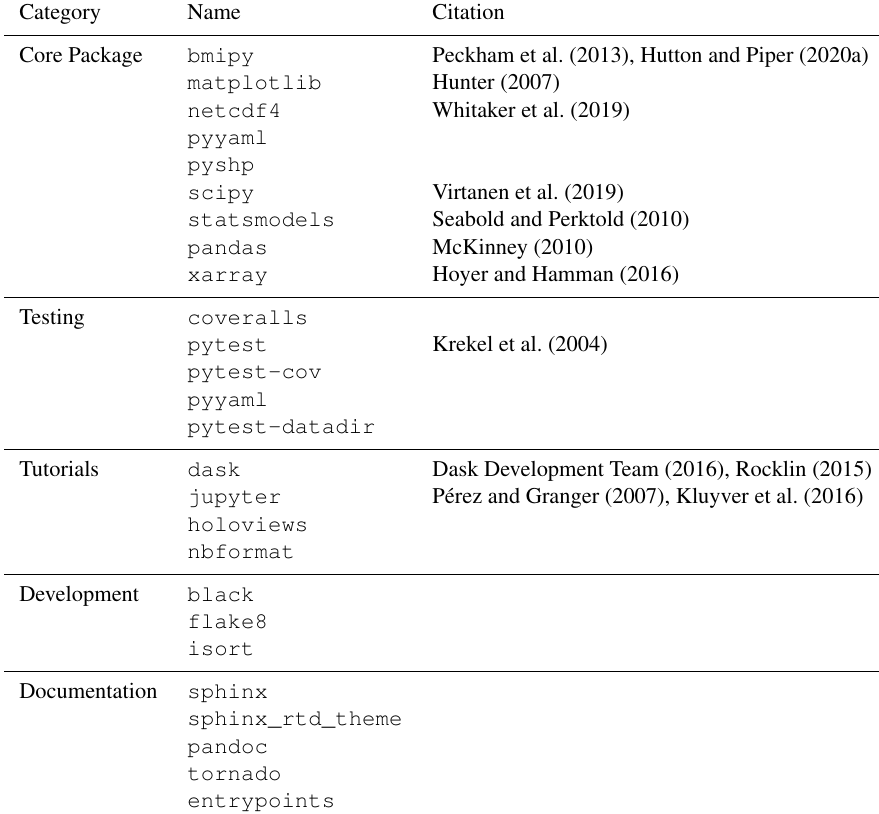
Table 5. Dependencies and citations.